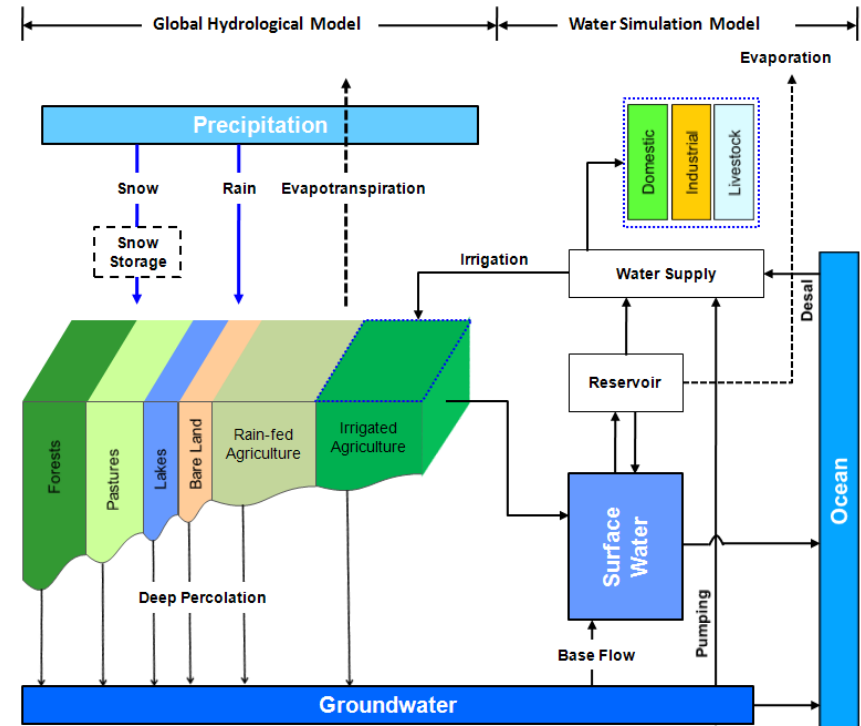
Figure 2. Structures of and linkage between the semi-distributed hydrological model and the water simulation module of the International Model for Policy Analysis of Agricultural Commodities and Trade